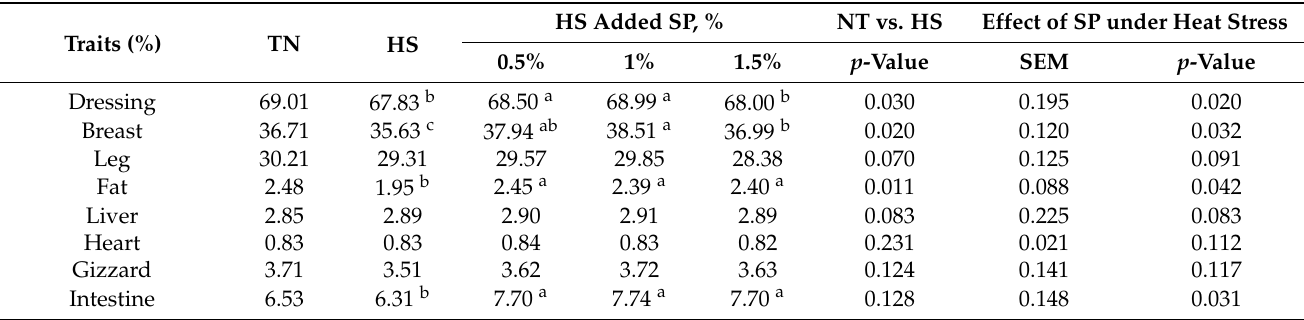
Table 6. Effect of dietary Spirulina platensis supplementation at different levels on carcass characteristics of broiler chickens subjected to cyclic heat stress starting from 22 to 42 days of age.